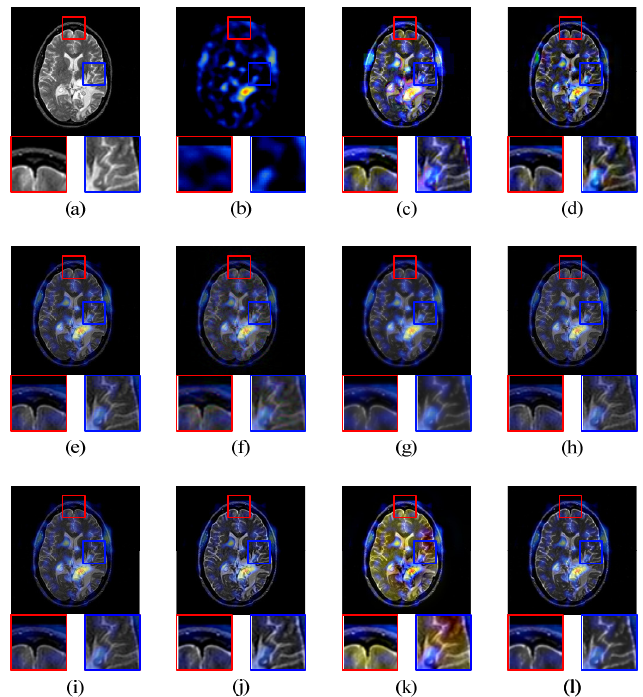
Figure 8. MRI-SPECT Image Fusion Comparative Experiments, ( a ) is the MRI source image; ( b ) is the SPECT source image; and ( c )–( l ) are the fused images of BSD, DWT, DT-CWT, CS-DCT, KSVD-OMP, MFR, SRDL, JPC, MST-SR, and the proposed IDLE